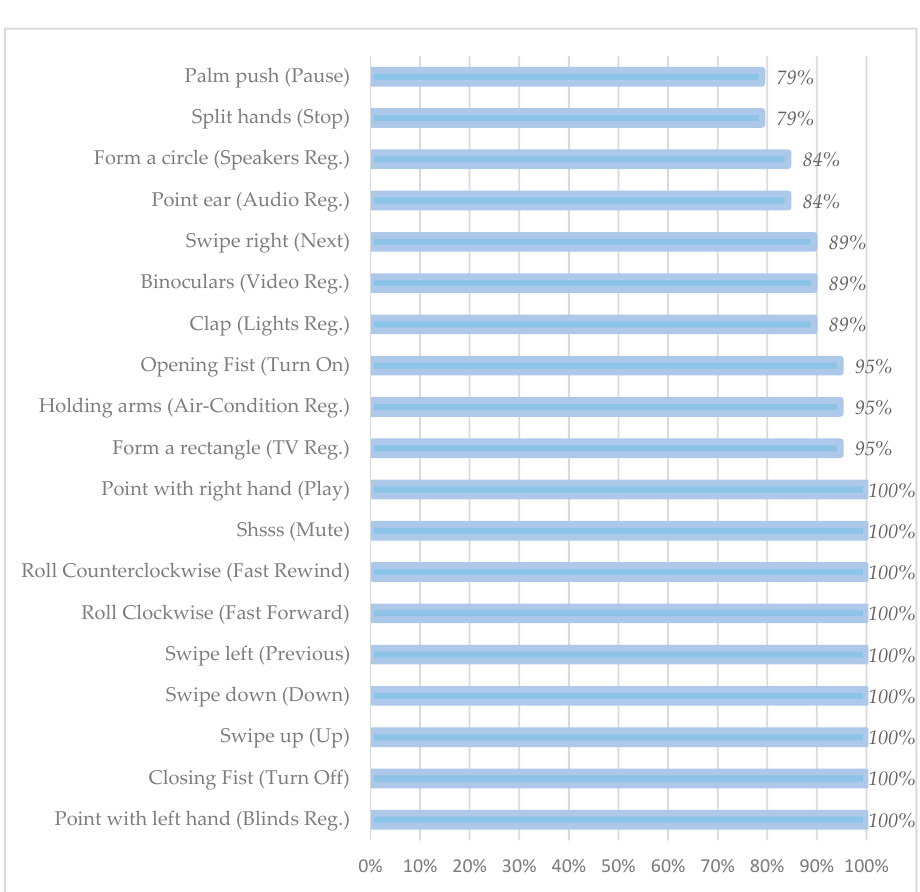
Figure 6. Memorability ratio.